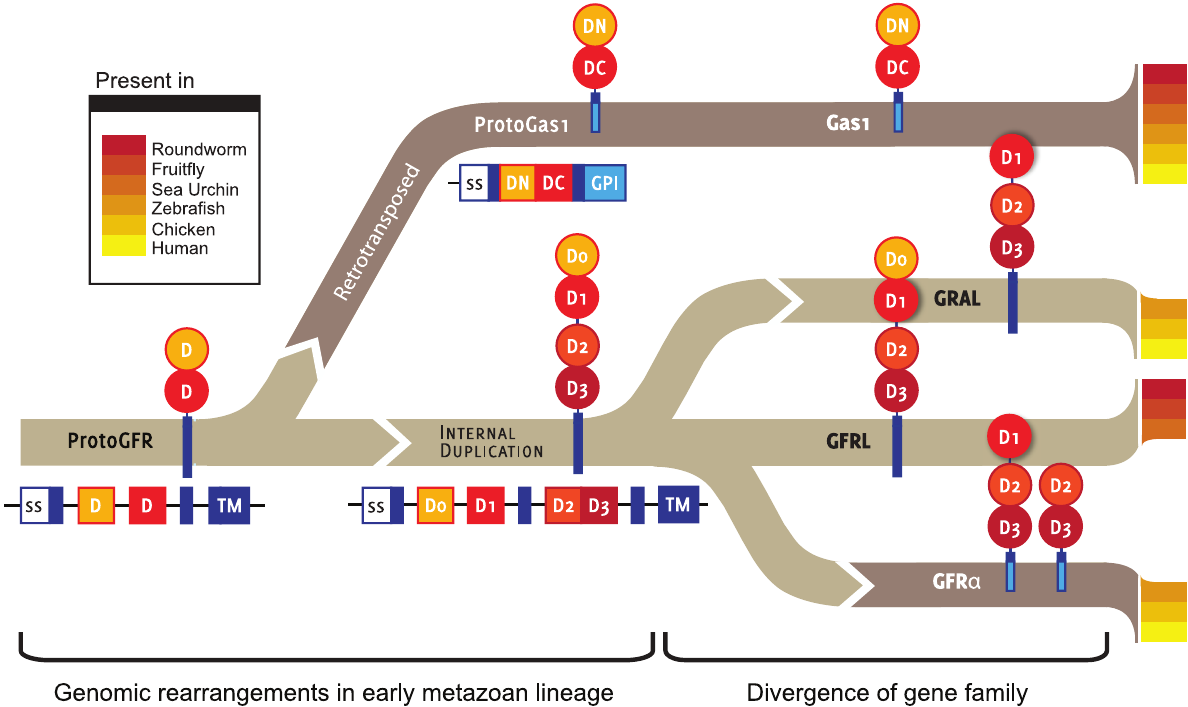
Figure 7. Precedent of retroposition event leading to a subbranch of GPI-anchored proteins within family of transmembrane proteins. Schematic representation of proposed mode of evolution of glial cell-derived neurotrophic factor (GDNF) family ligand receptor (GFR a ) members. Horizontal and vertical cartoons depict modular gene and protein organization of GFR a members, respectively. Please note both the absence of introns and the emergence of the GPI membrane attachment mode in the Gas1 subbranch of GFR a proteins following a retroposition event which occurred early during metazoan speciation.